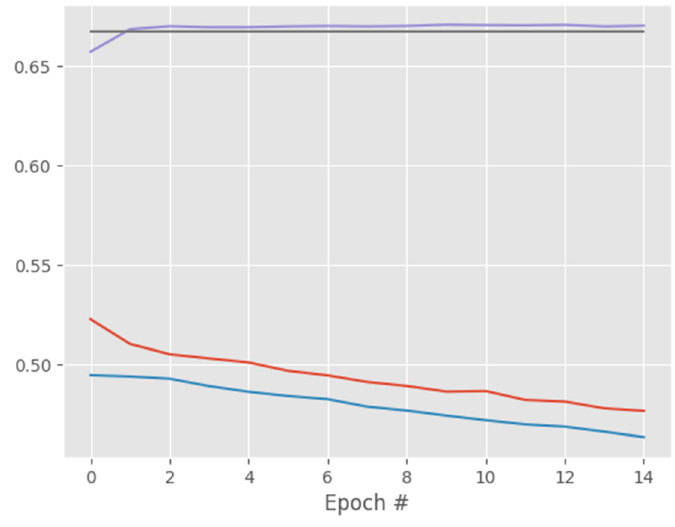
Figure 16. ResNet50 training and validation performance for X-ray images.